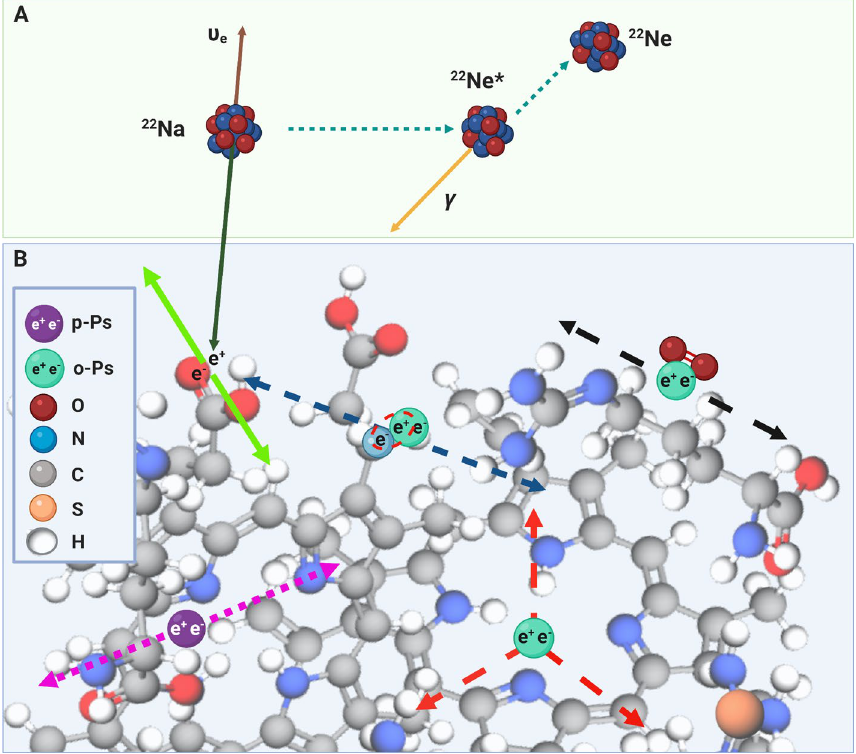
Fig. 1 A pictorial illustration of the basic processes leading to the formation and decay of positronium in the intramolecular voids of a hemoglobin molecule. We have used a sodium 22 Na isotope as an emitter of positrons (e ), considering the role of sodium fluoride in cardiovascular imaging [34, 37]. a 22 Na radionuclide + decays emitting a neutrino (brown arrow) and a positron (dark green arrow) (e ), and turns into an excited + 22 Ne* nucleus. It de-excites almost instantly (on an average in 3 ps) by the emission of the prompt photon (yellow arrow). b The positron thermalizes at a distance of about 1 mm [38], and annihilates into photons with one of the electrons (e − ) in the surrounding molecules. Positron–electron annihilation in the tissue undergoes direct annihilation into two photons (solid light green arrows) in roughly 60% of the cases. However, it proceeds via the formation of positronium atom in 40% of the cases. The latter may be trapped in the tissue in the intramolecular voids [39]. Positronium atom can be created in two forms: (i) short-lived (125 ps) para-Positronium (p-Ps indicated in purple), which decays into two photons (dotted pink arrows) or (ii) long-lived (142 ns) ortho-Positronium (o-Ps indicated in mint), which decays into three photons (dashed red arrows). In the tissue, o-Ps predominantly annihilates either through an interaction with an electron (e − ) from the surrounding molecule via pick-off process (dashed blue arrows) or through the conversion to p-Ps via an interaction with oxygen molecules, which subsequently decays into two photons (dashed black arrows) [16, 40]. These processes decrease the o-Ps lifetime, which becomes strongly dependent on the size of intramolecular voids and the concentration of bioactive